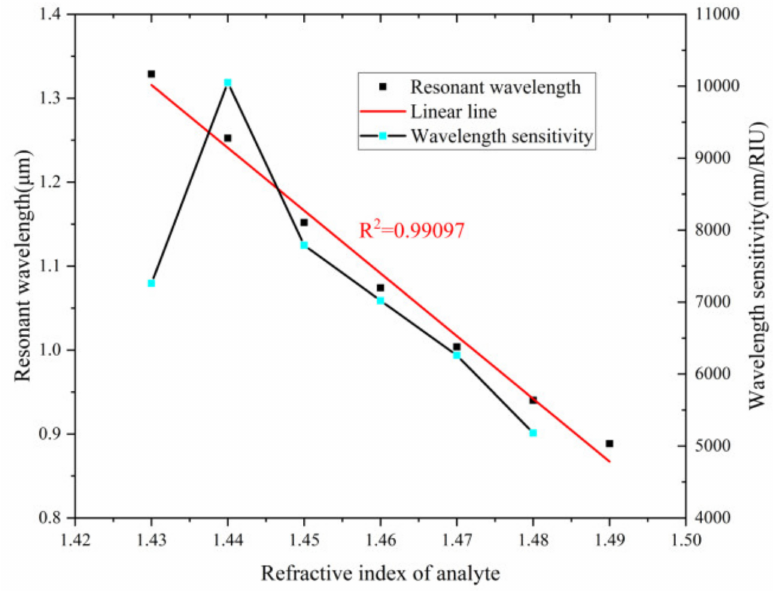
Figure 5. The resonance wavelength and wavelength sensitivity as a function of n a .